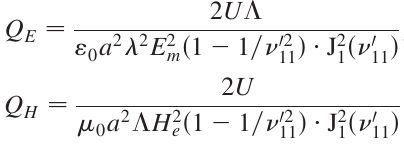
ffiffiffiffiffiffiffiffiffiffiffiffiffiffiffi p (cid:2) 1 (cid:2) (cid:5) 2 ffiffiffiffiffiffiffiffiffiffiffiffiffiffiffi p þ 1 (cid:2) (cid:5) 2